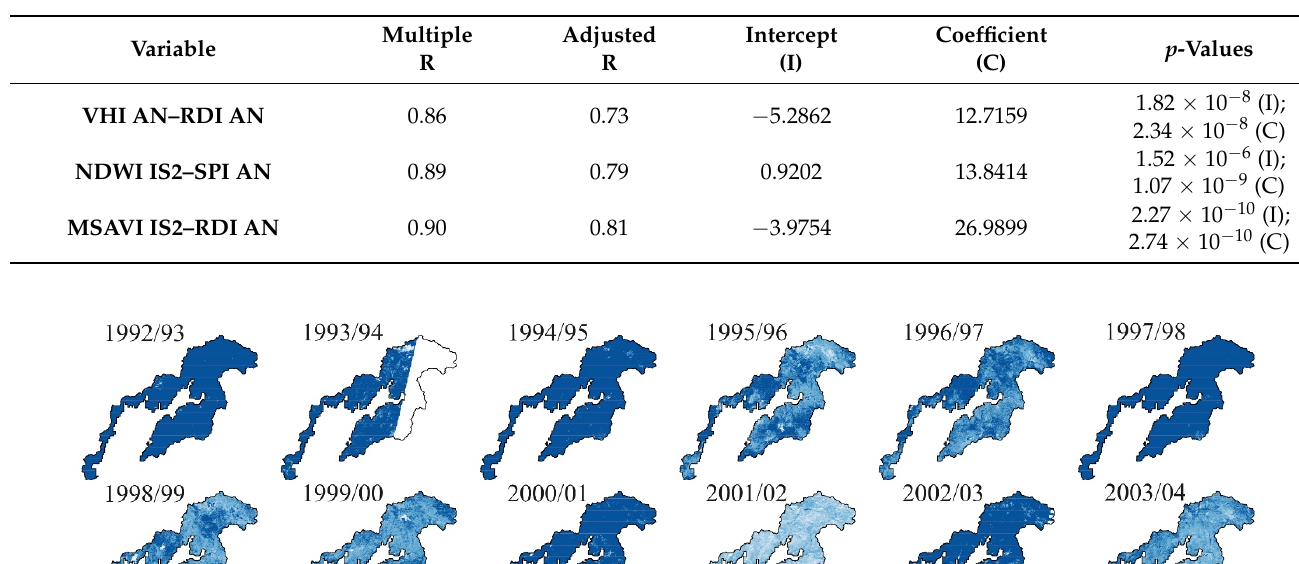
Table 5. Linear regression models for three selected surface reflectance-derived drought indices (VHI, NDWI, MSAVI) and seasons (intervening season 2, IS2; annual, AN) and the annual meteorological drought indices (Reconnaissance Drought Index, RDI; Standardized Precipitation Index, SPI) to assess drought classification, affected area, and duration at the Guadalupe Valley Basin, Baja California, Mexico.